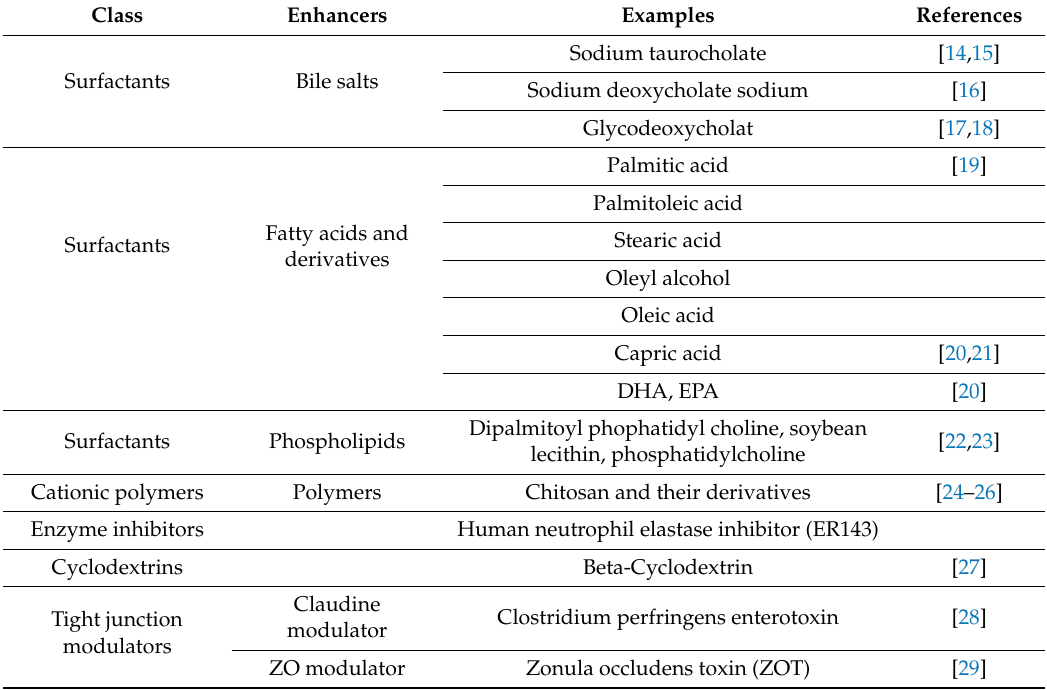
Table 1. Common absorption permeation enhancers- application for nasal and pulmonary